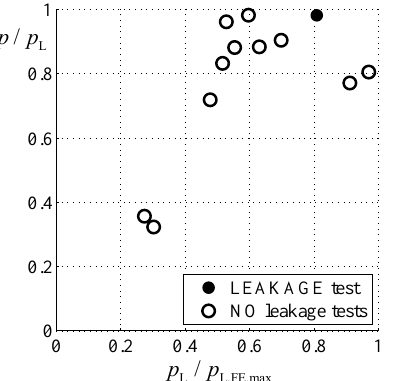
Figura 8: Prove in piena scala di pressurizzazione. Corretta previsione, mediante il modello analitico, del singolo caso di